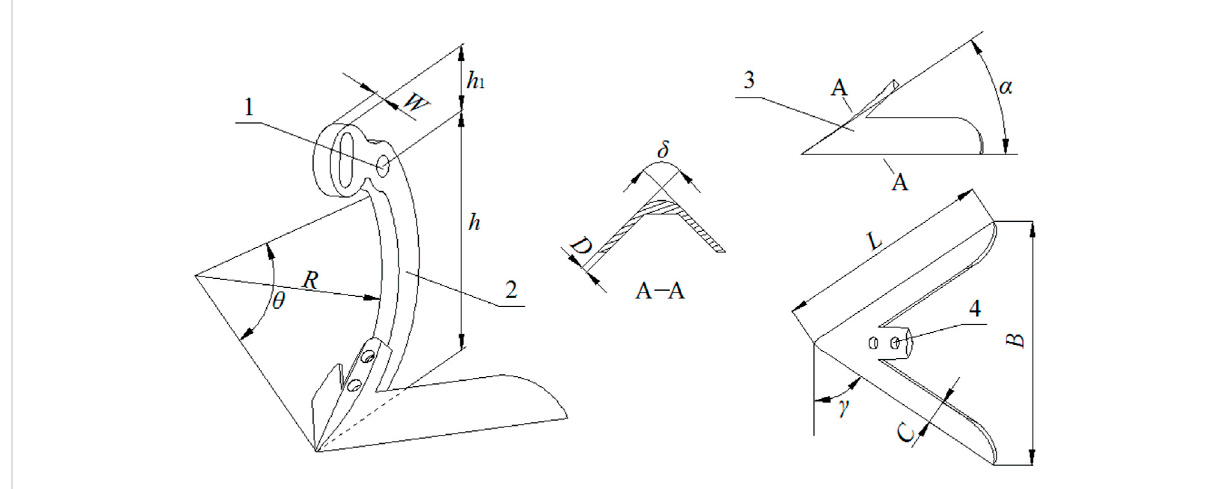
FIGURE 1 Schematic of the subsoiler structure: (1) hole for connecting bolting shaft to testbed; (2) shaft; (3) point; and (4) hole for connection of bolting point to shaft.